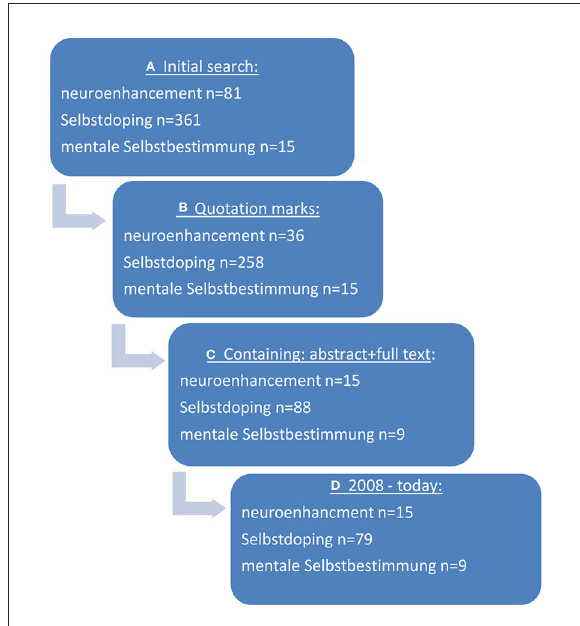
FIGURE2 Search strategy in “juris” and “beck-online” for the search terms “neuroenhancement,” “Selbstdoping,” and “mentale Selbstbestimmung” to find data about legal aspects of PN. (A) Initial search terms were used, (B) quotations marks were